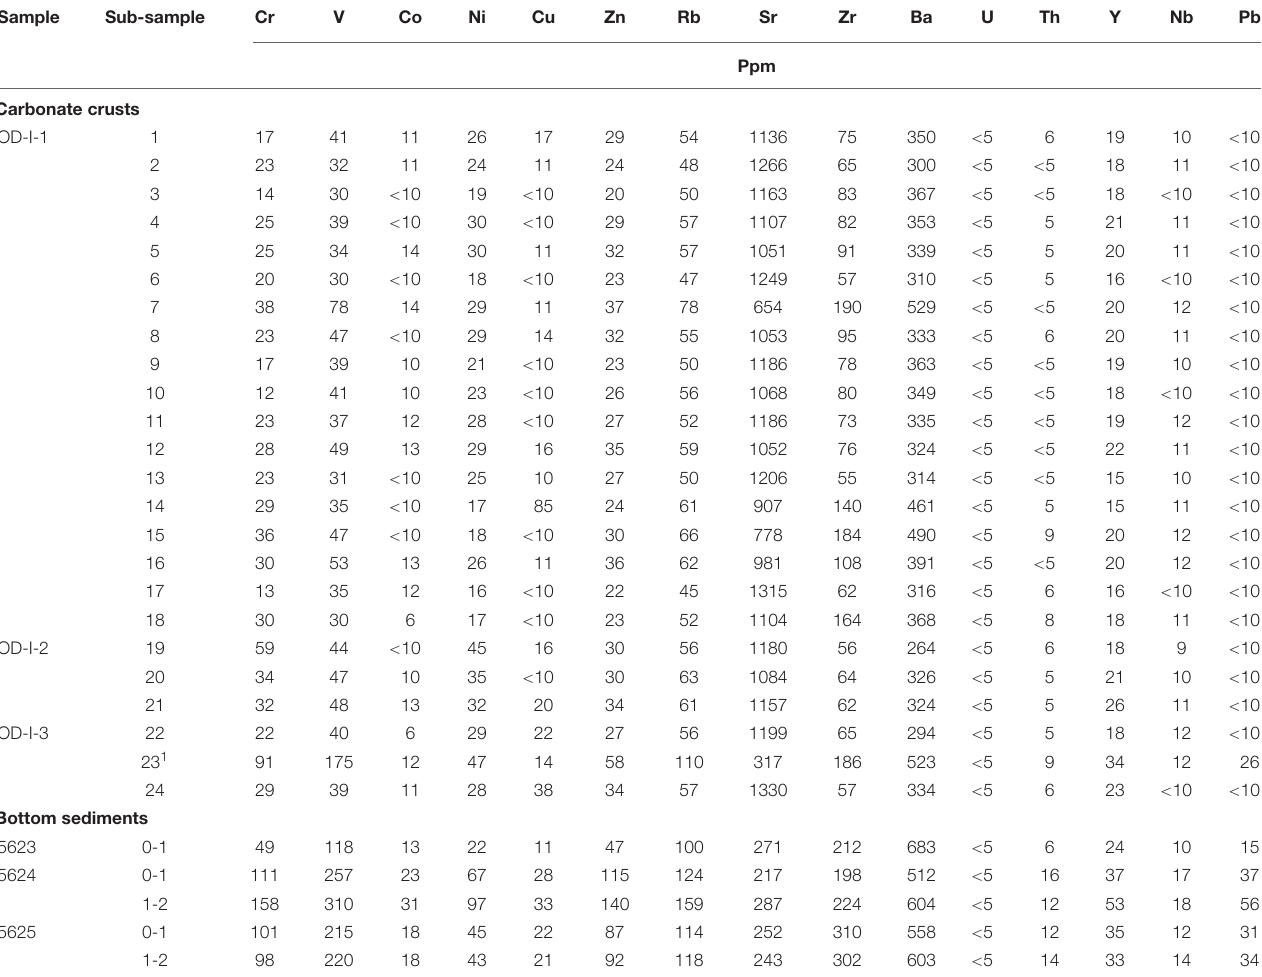
TABLE 4 | XRF trace element composition of the carbonate crust and sediment samples.